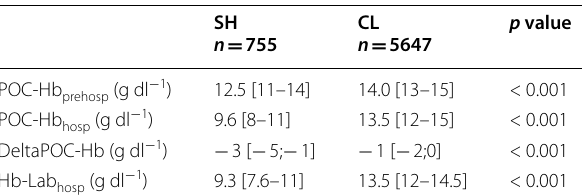
Table 2 Different hemoglobin measurements and variations